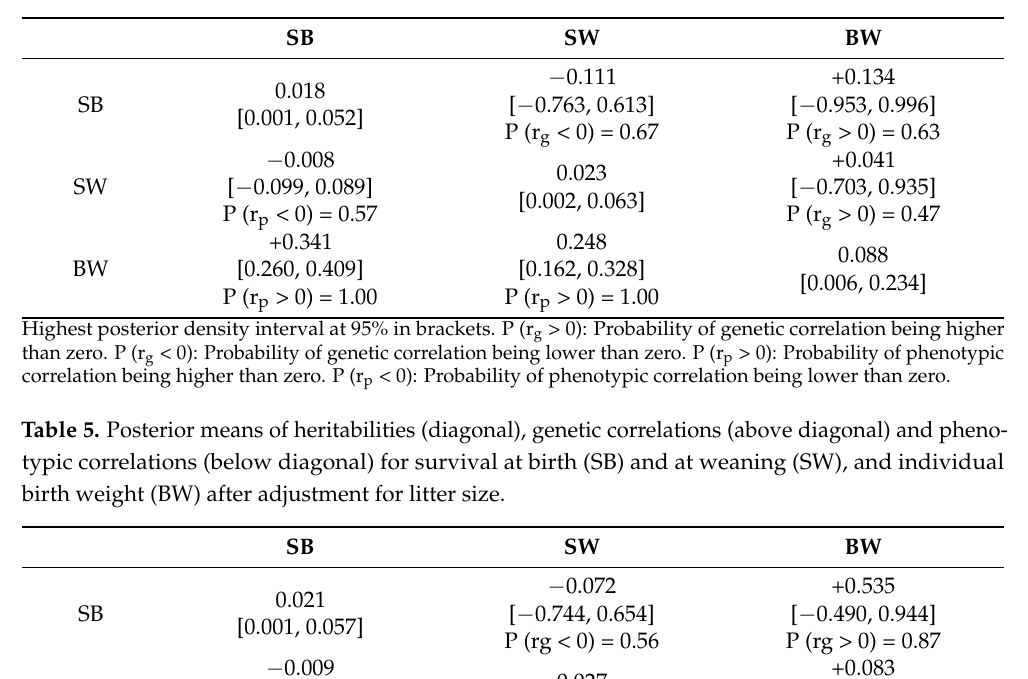
Table 4. Posterior means of heritabilities (diagonal), genetic correlations (above diagonal) and pheno- typic correlations (below diagonal) for survival at birth (SB) and at weaning (SW), and individual birth weight (BW).